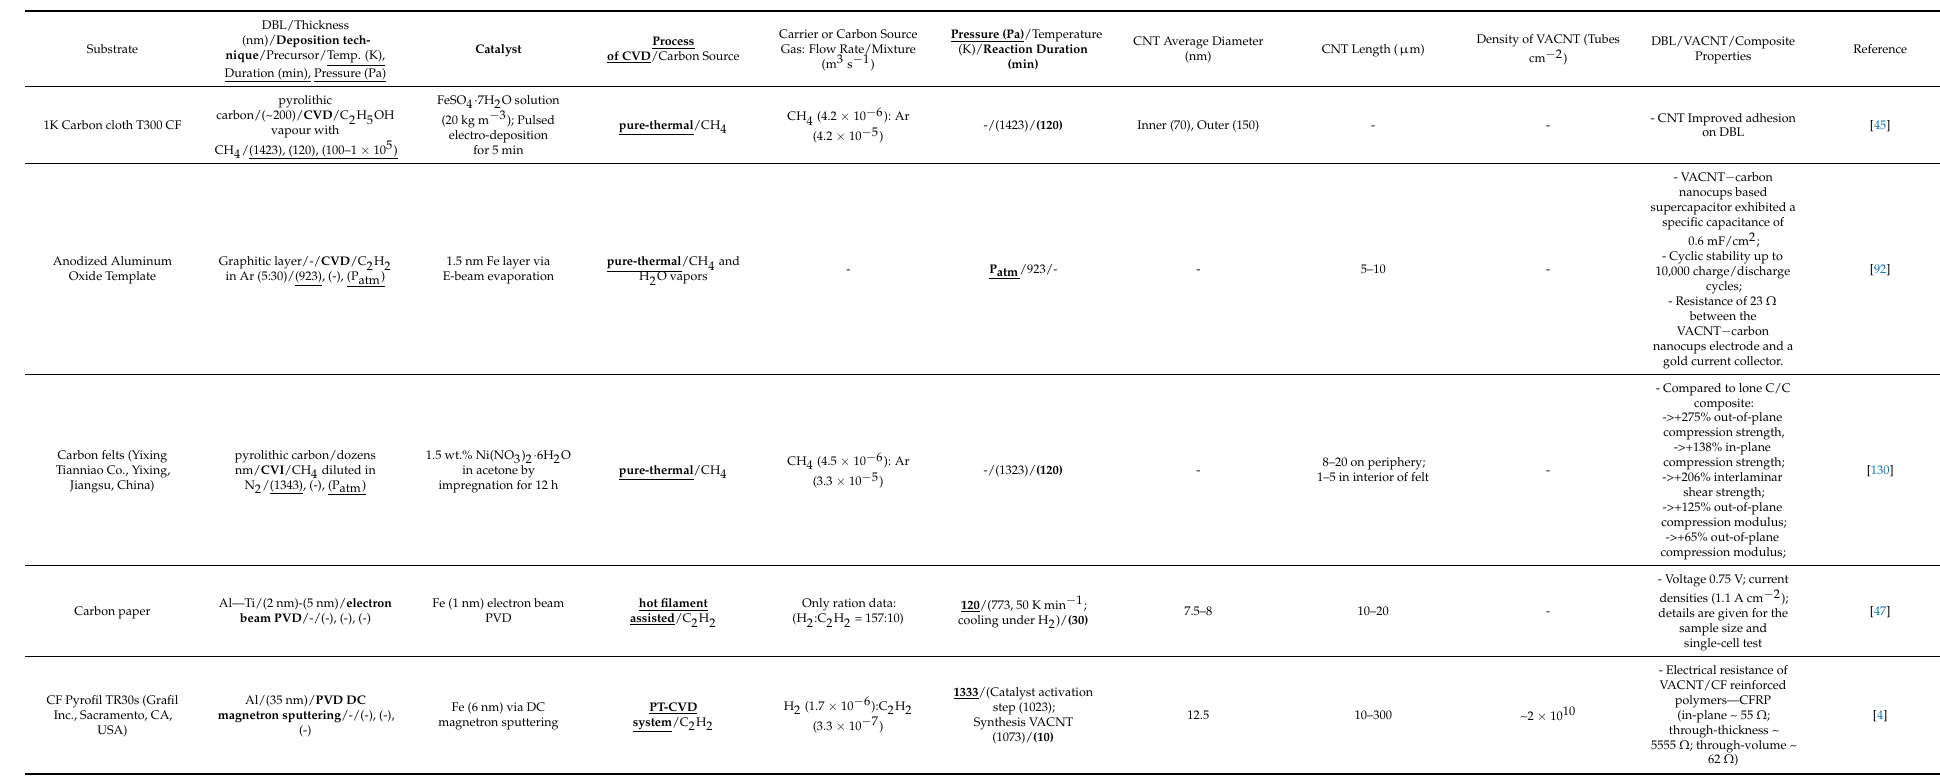
Table 9. Details of used CF substrates for growth of VACNT with the use of CVD/PVD deposited